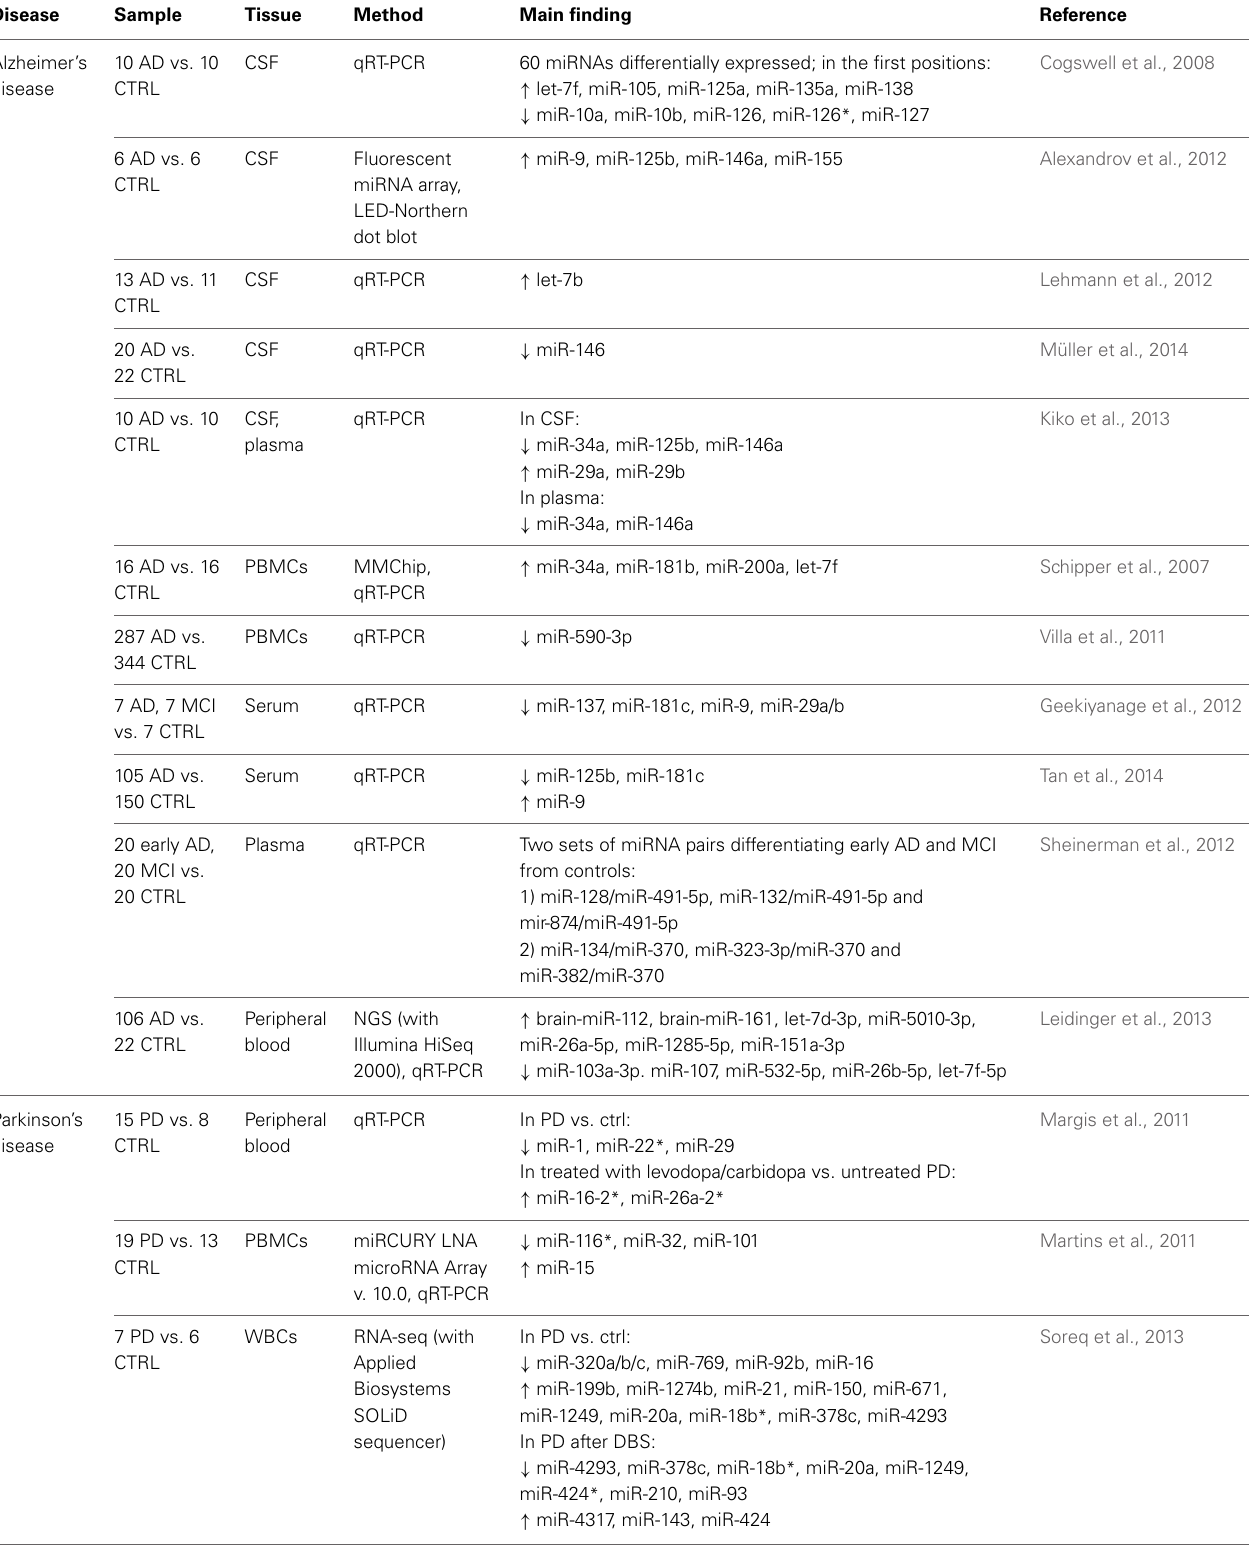
Table 2 | microRNA expression studies in neurologic disorders.